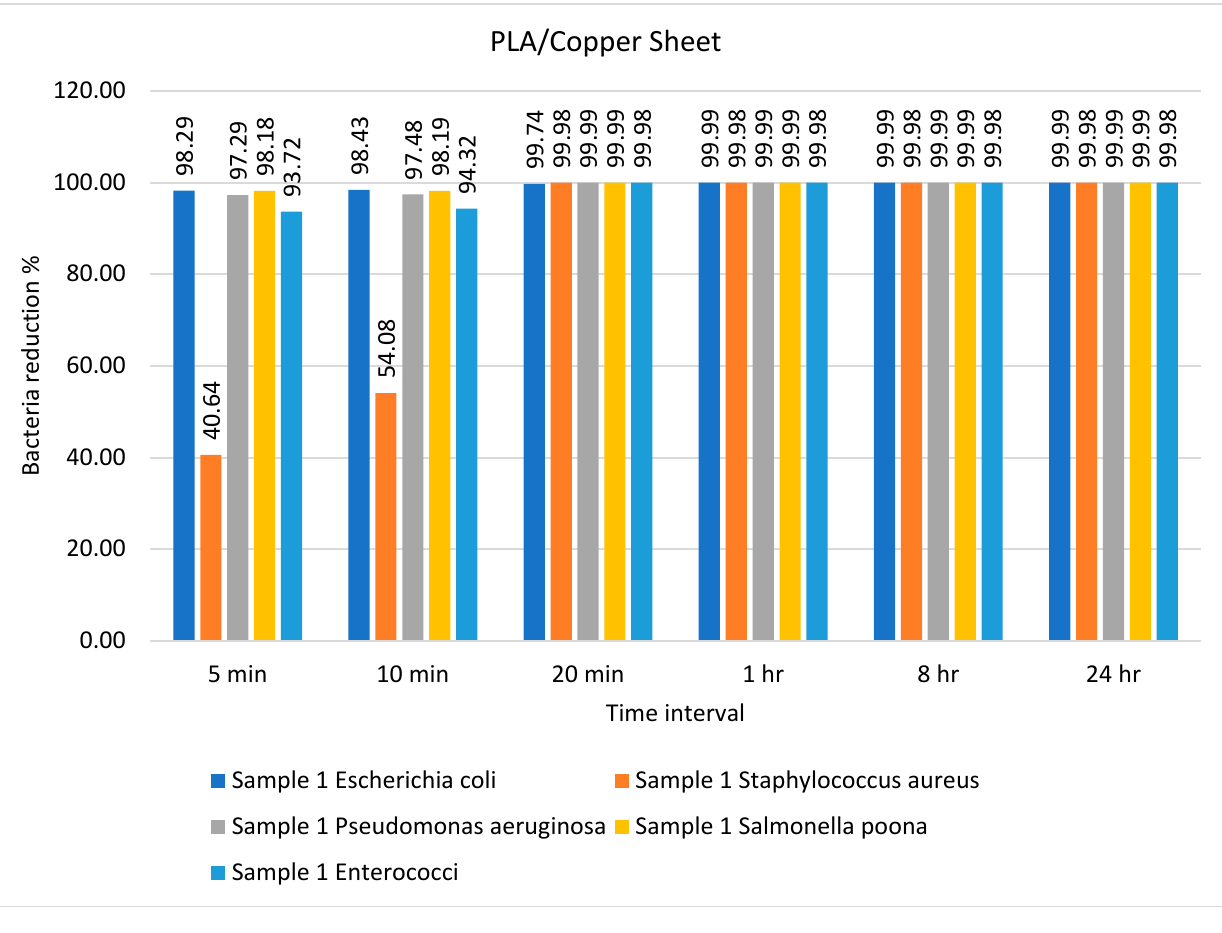
Table 3. Bacterial count on PLA/aluminum-6061 sheet over different time